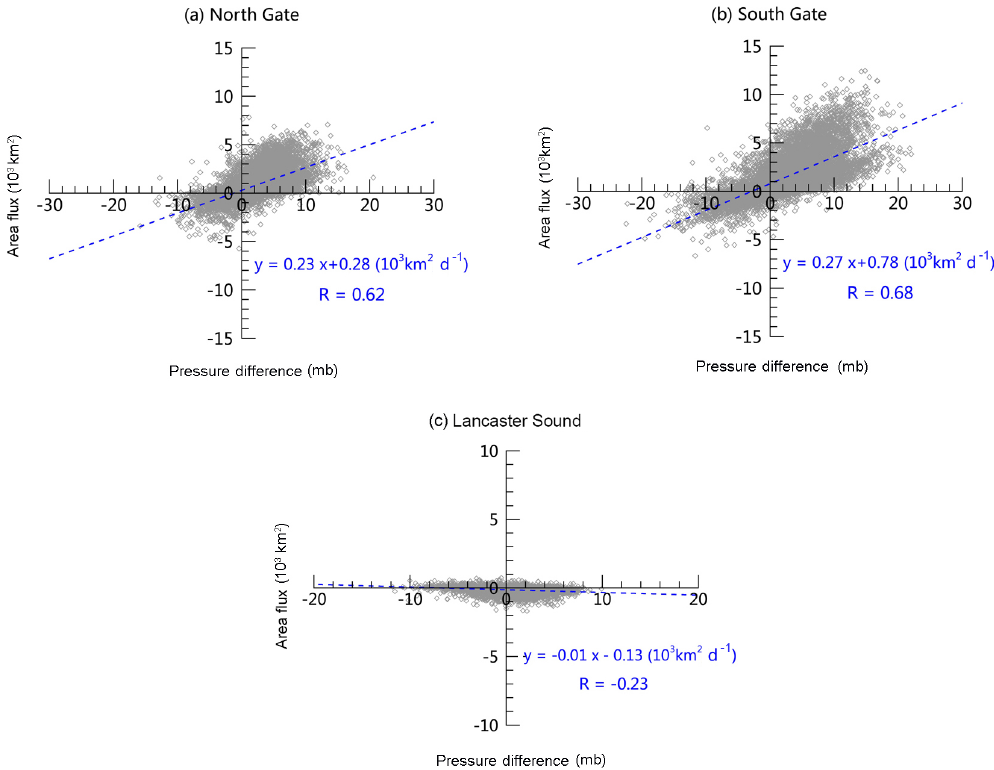
Figure 14. Scatterplot of daily sea ice area flux and cross-gate pressure differences for (a) the northern gate, (b) the southern gate, and (c) Lancaster